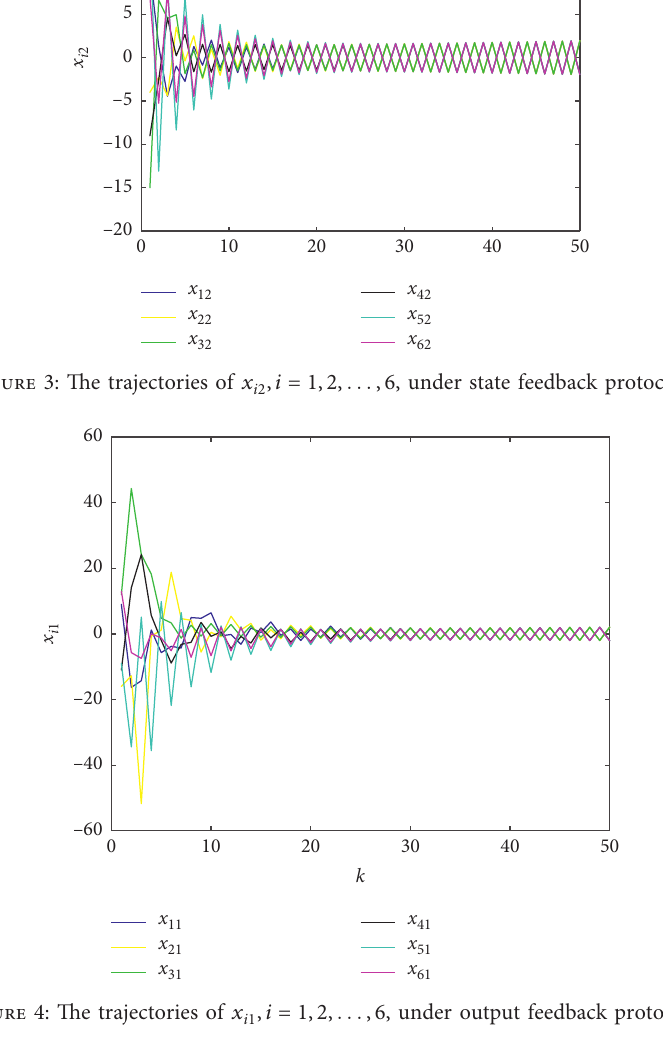
Figure 4: The trajectories of x